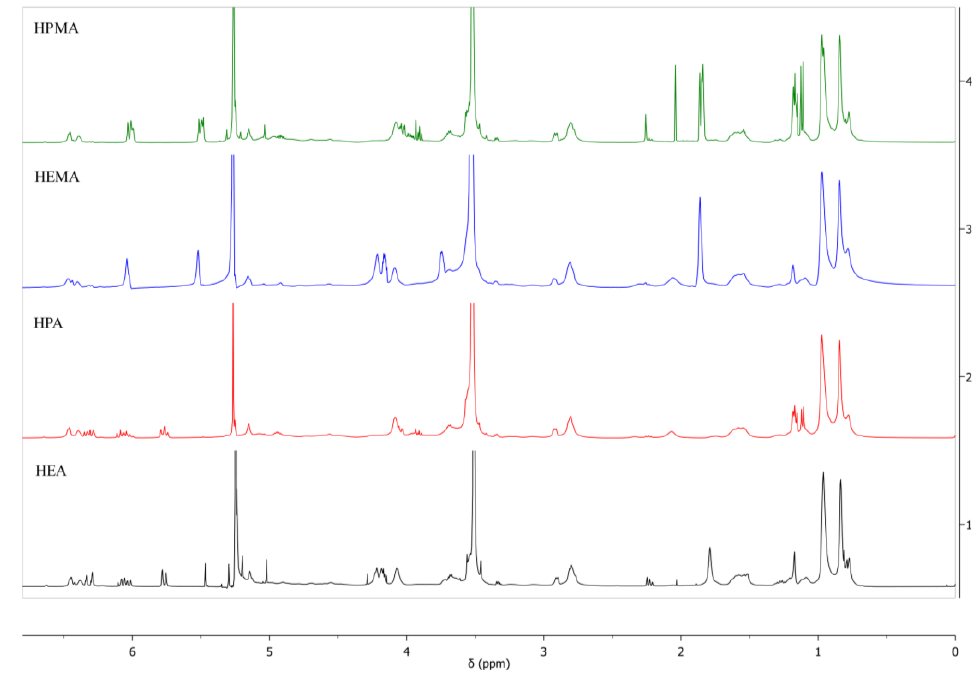
Figure 4. 1 H NMR spectra of urethane (meth)acrylates obtained.